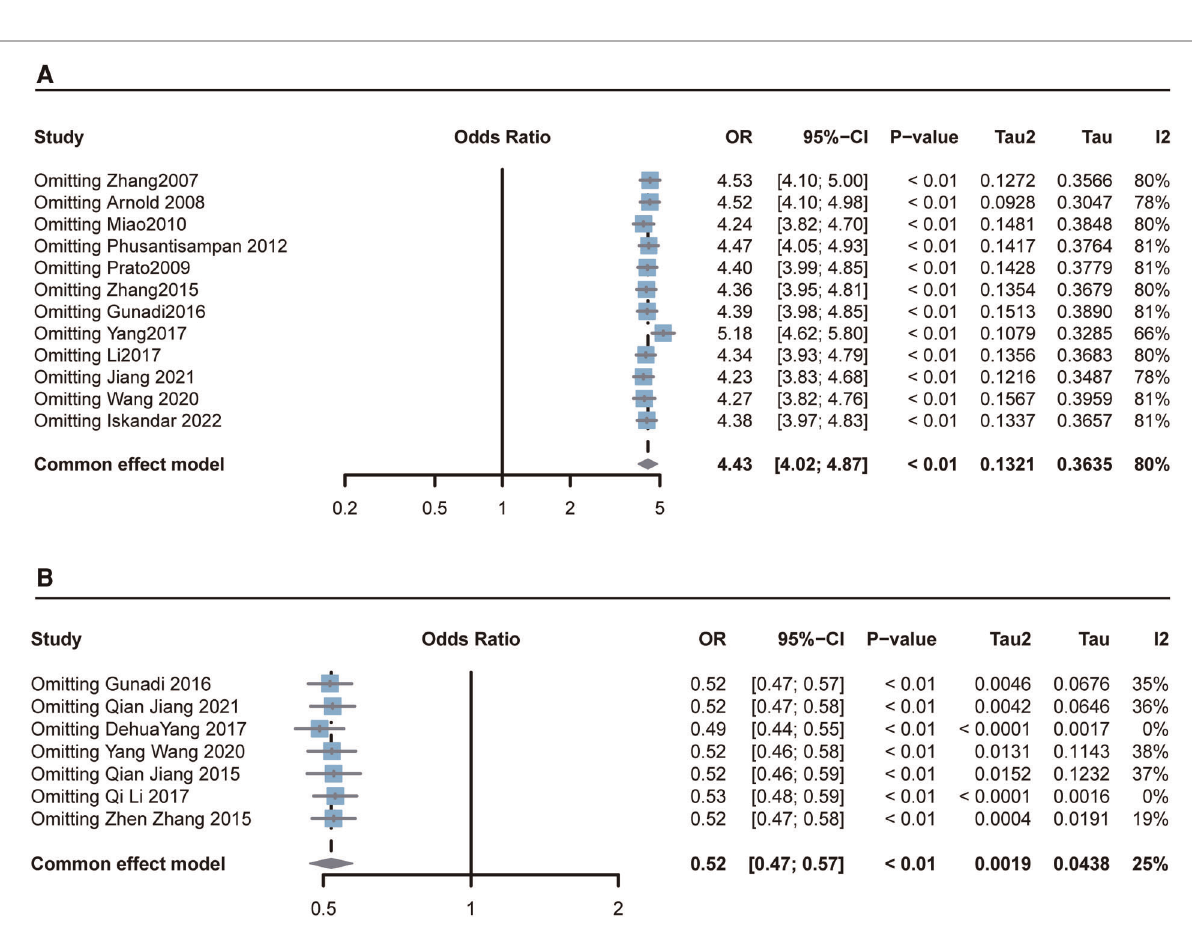
FIGURE 3 Forest plots of the sensitivity of the meta-analysis. ( A ) rs2435357 (allele model); ( B ) rs2506030 (allele